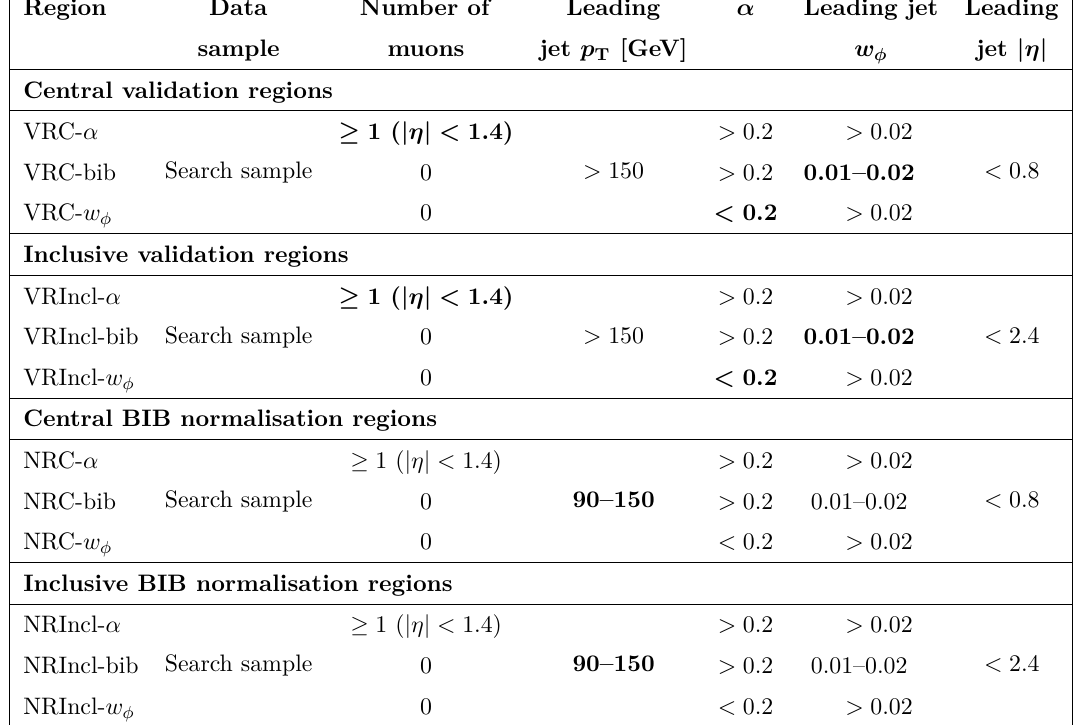
Table 4 . Overview of the validation regions and the low- p T regions used to normalise the BIB templates for the corresponding validation region. A central set and an inclusive set of these regions are defined to test the background modelling in both SRC and SRIncl. The VRs are also checked separately using data from 2017 and from 2018 to ensure consistent background modelling in both years. The main requirements that distinguish the validation regions from the signal regions, and the normalisation regions from the validation regions, are indicated in boldface. Events for which α cannot be determined are included in the α > 0 . 2 selection in VR(Incl/C)- α , VR(Incl/C)-bib and the corresponding